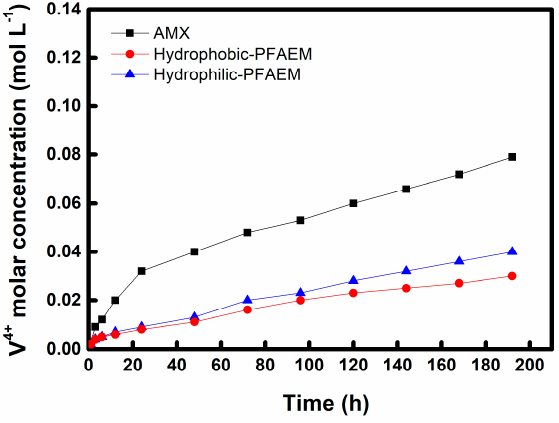
Figure 9. Time course changes in V 4+ ion concentration during the oxidative stability tests of AEMs.